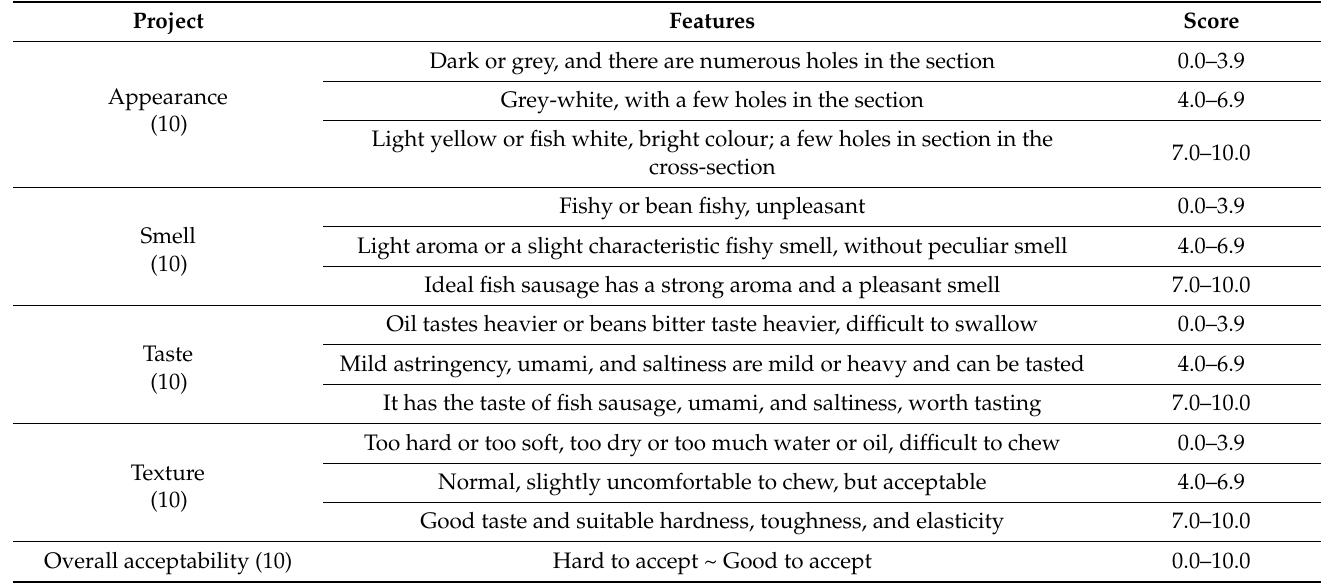
Table 1. Scoring criteria for sensory evaluation of grass carp